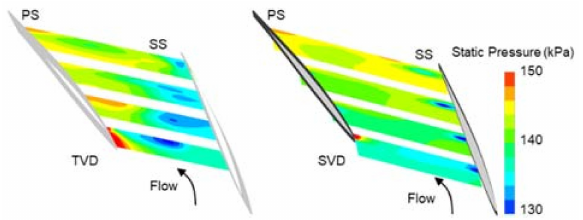
Figure 11. Distribution of static pressure in diffuser passages ( ϕ = 0.7 Q d